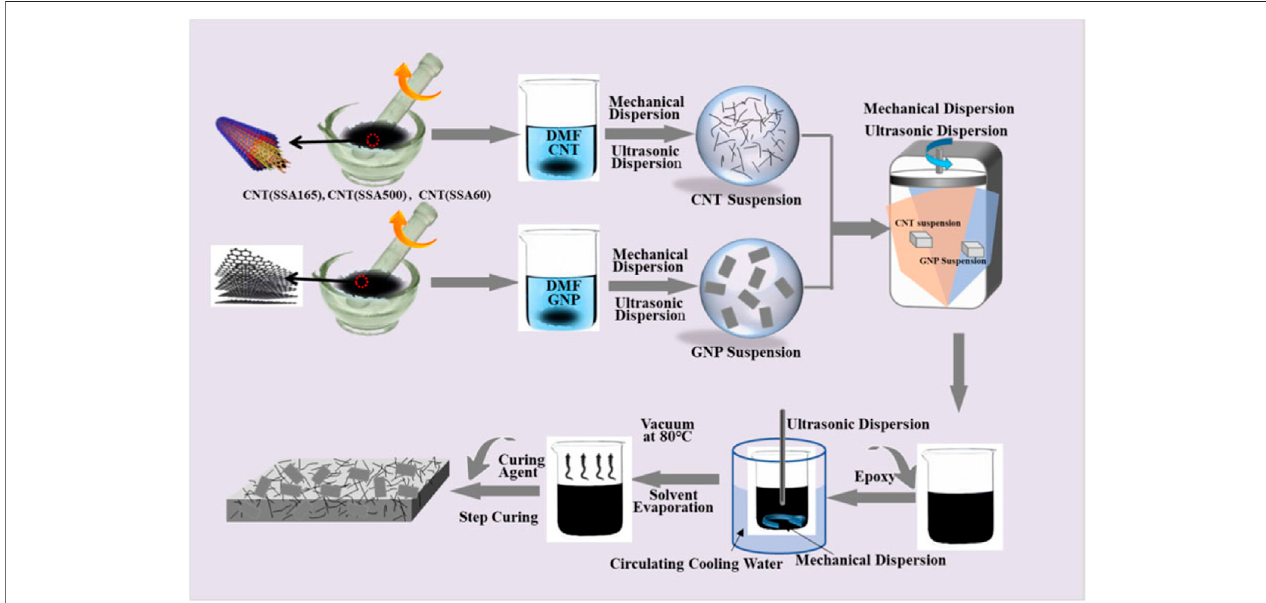
FIGURE 1 | Preparation process schematic of the composites for asphalt pavement strain monitoring.